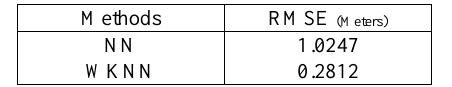
Table 2. RMSE for positioning methods in the first scenario